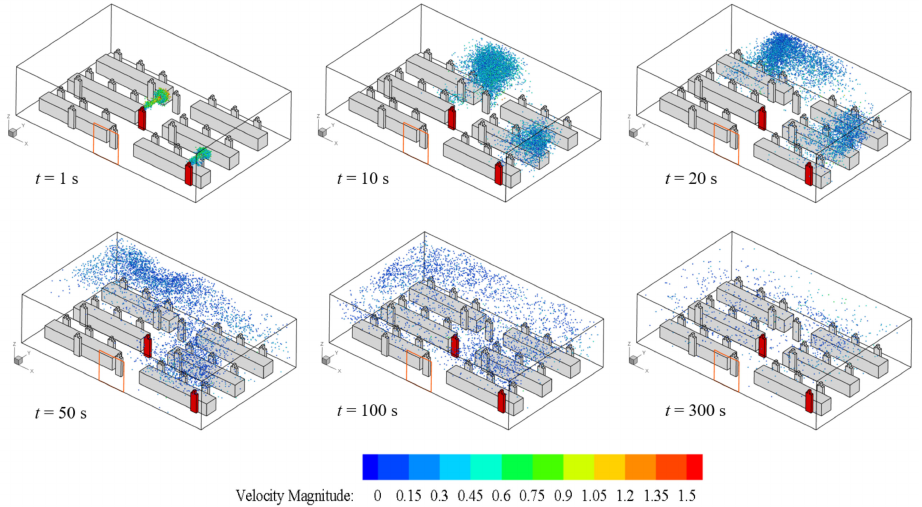
Figure 5. Distribution of aerosols in case 1 (only the front door is open).